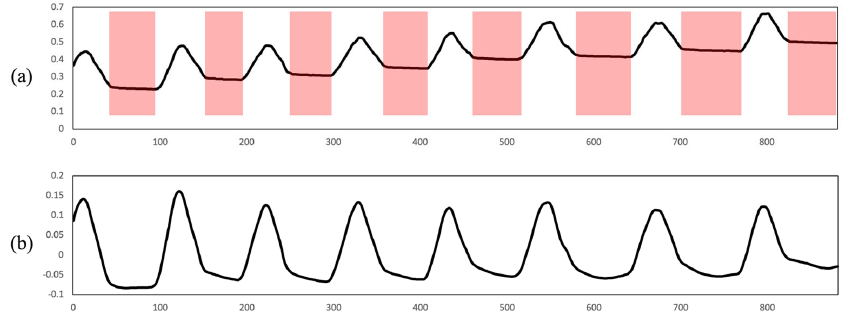
Figure 7. Examples of trended raw signals and detrending results: ( a ) raw signals, ( b ) detrending results.